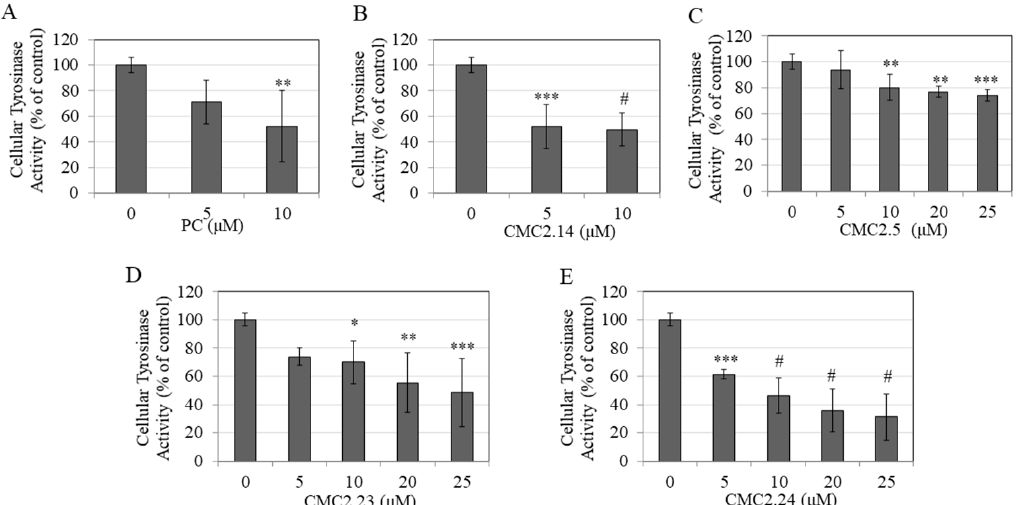
Figure 6. Tyrosinase activity in B16F10 cells treated for 48 h with different concentrations of compounds; ( A ) PC; ( B ) CMC2.14; ( C ) CMC2.5; ( D ) CMC2.23 and; ( E ) CMC2.24. KA (500 µM) was used as a positive control. One-way ANOVA and Dunnett’s post hoc test; * p < 0.05; ** p < 0.01; *** p < 0.001; and # p < 0.0001 vs. control. One-way ANOVA with Dunnett’s post hoc test. All data are mean ± SD of values pooled from two independent experiments.